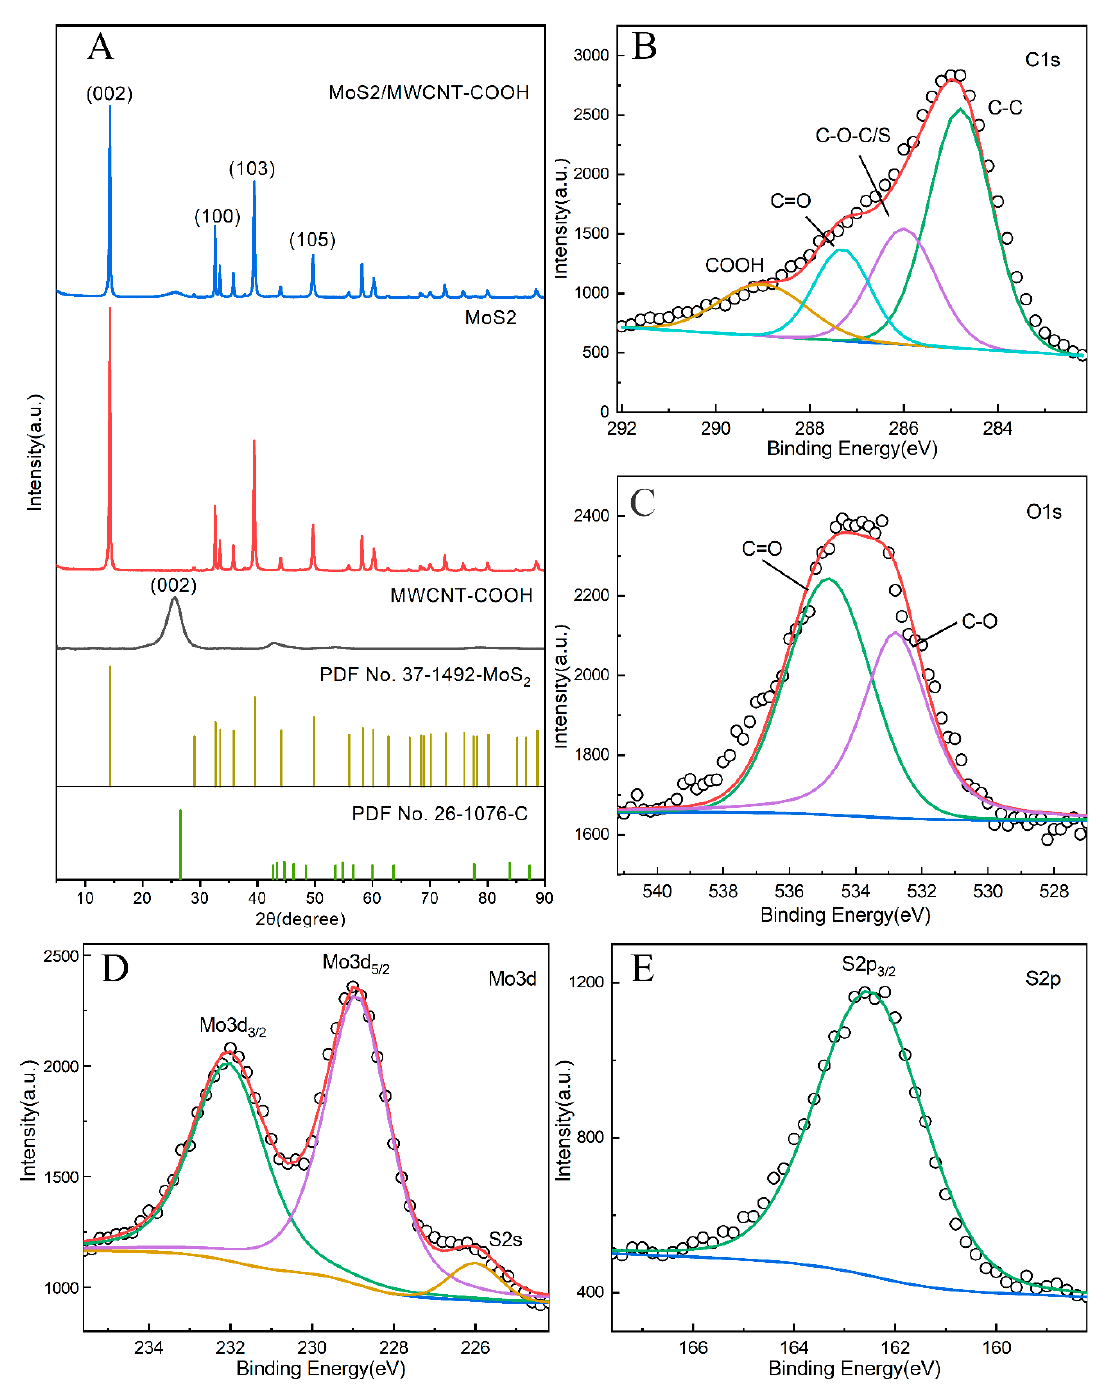
Figure 1. XRD spectra ( A ) of MoS 2 , MWCNT, MoS 2 /MWCNT-COOH, XPS spectra of C1s ( B ), O1s ( C ), Mo3d ( D ), S2p ( E ).